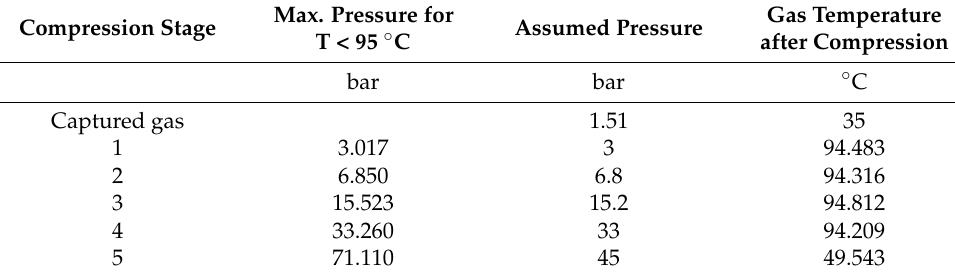
Table 4. Pressures and temperatures of the gas stream after each compression cycle.